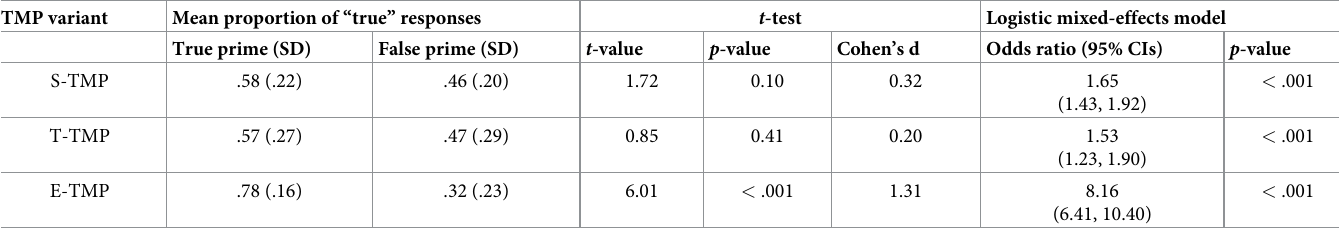
Table 1. Results (t-test and LMMs) for each of the three TMP variants in Experiment 1. TMP variant Mean proportion of “true”